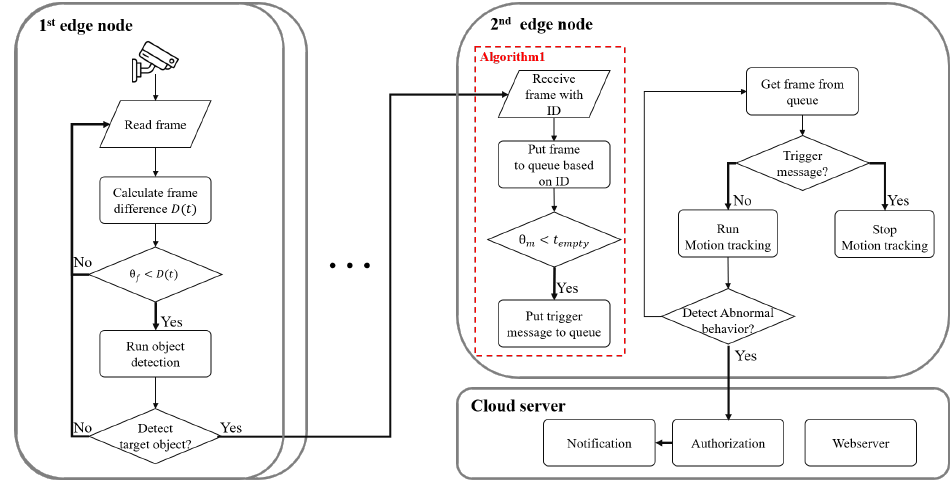
Figure 3. Flow diagram of the proposed AdaMM framework with multiple 1st edge nodes.